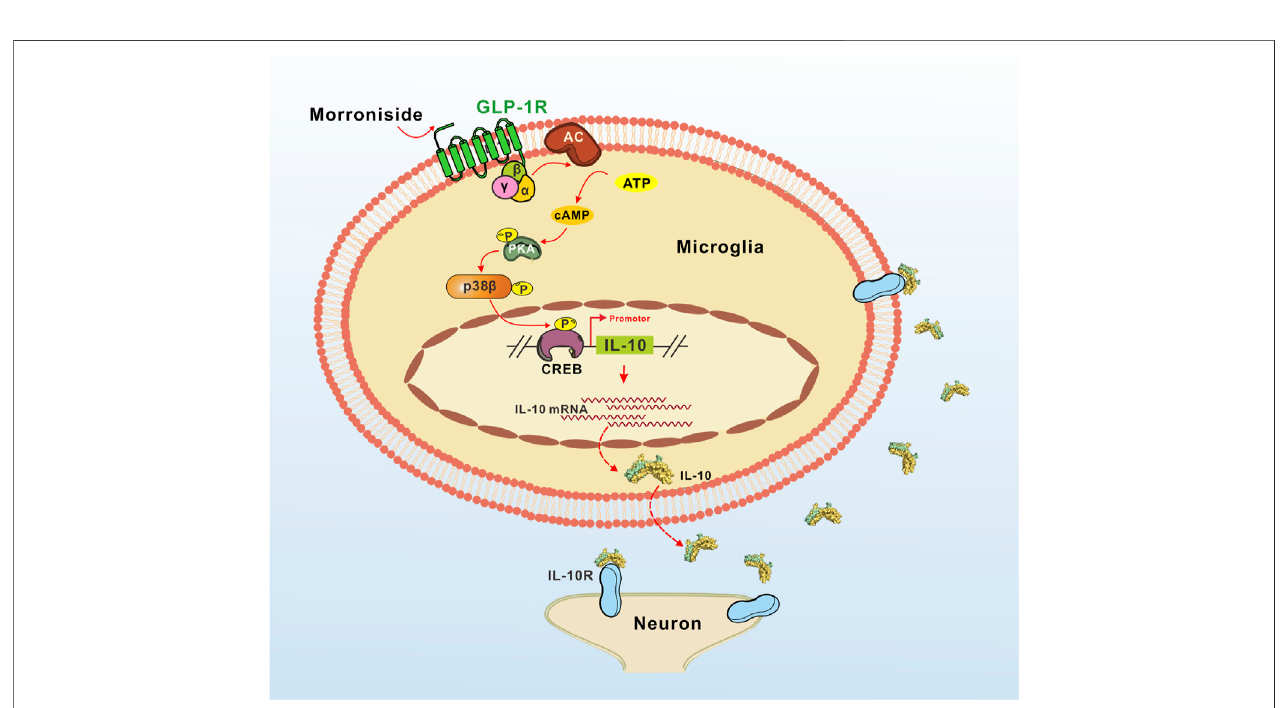
FIGURE5| IllustrationoftheproposedIL-10expressioninducedbyGLP-1RagonistmorronisideinMCAOmice.AsthemainpathwayofGLP-1R,thecAMP/PKA/ p38 β signal cascade mediated IL-10 expression and secretion. According to our viewpoints in general, the secreted IL-10 then might play a neuroprotective effect by anti-in fl ammation and anti-apoptosis.